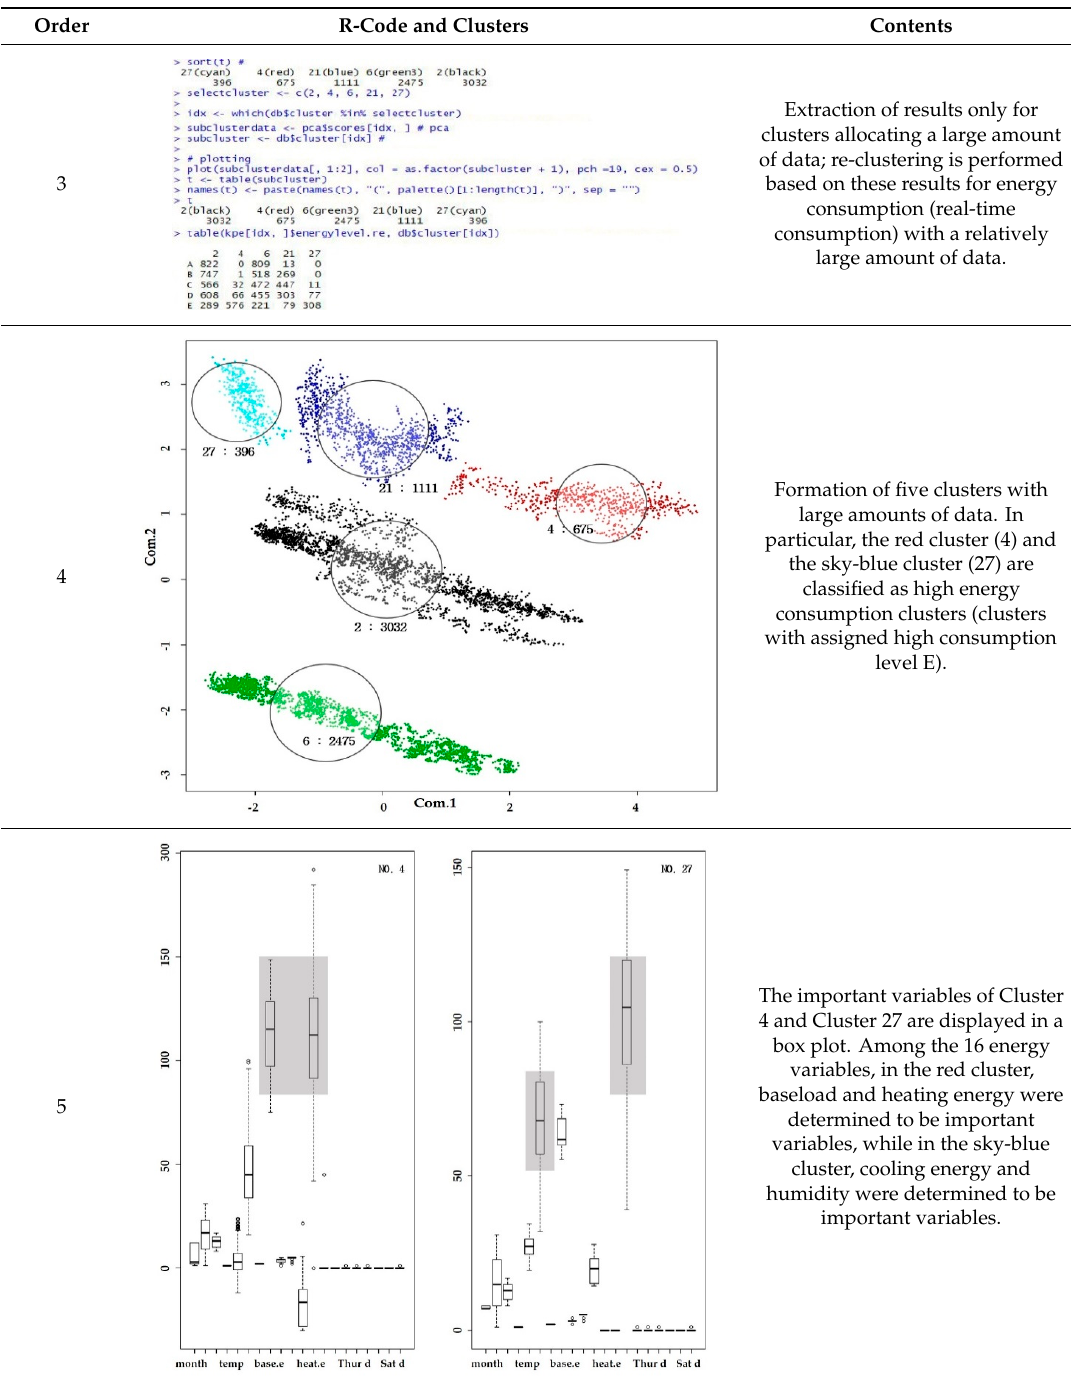
Figure 3. Result of DBSCAN